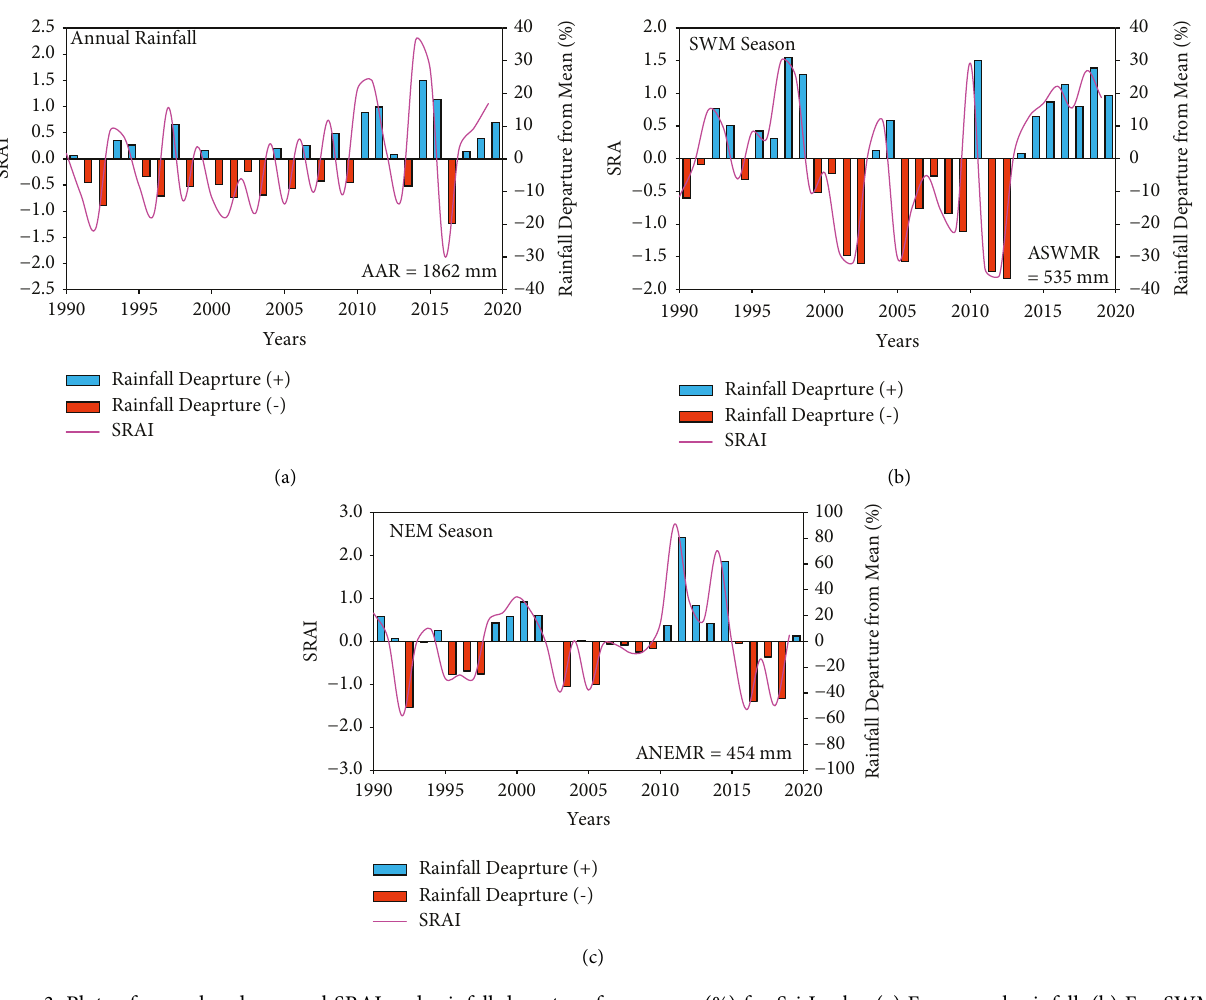
Figure 3: Plots of annual and seasonal SRAI and rainfall departure from mean (%) for Sri Lanka. (a) For annual rainfall. (b) For SWM season. (c) For NEM season. Table 4: Station-wise wet and dry years observed in Sri Lanka based on SRAI